Question: Write a caption explaining this figure to a reader.
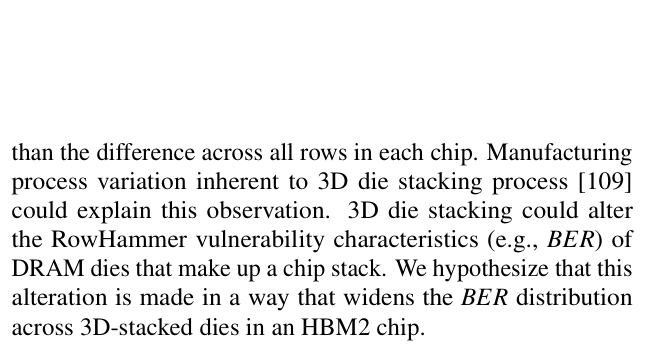
Answer: shows the distribution of HCfirst (y-axis) across differ- ent DRAM rows for a given data pattern (x-axis) in a channel (color-coded).